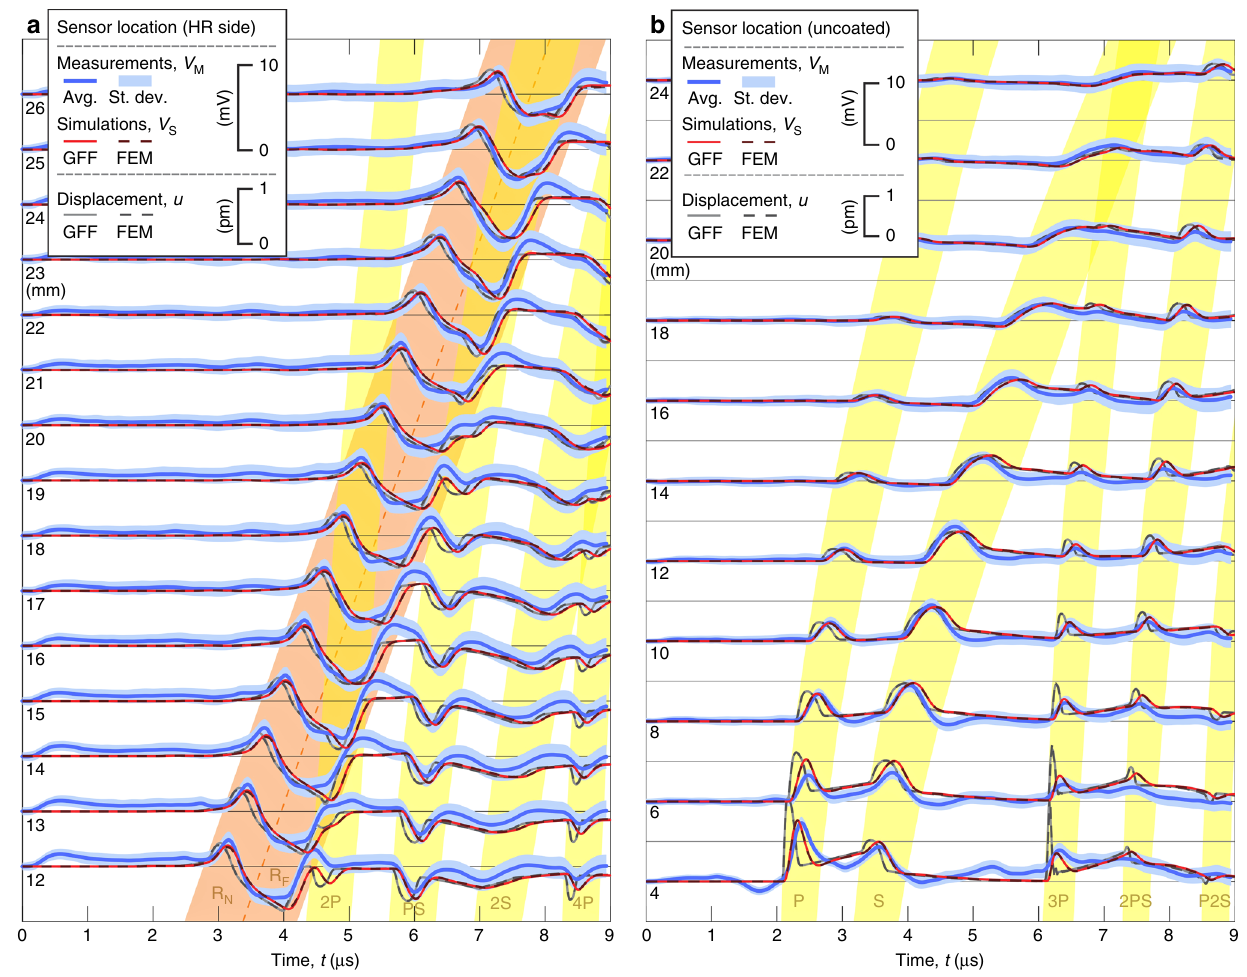
Fig. 2 Experimental and simulated picometer-scale normal surface displacements. The normal surface displacements are caused by the reverberations of radiation-pressure-driven elastic waves within a dielectric mirror. a The waveforms obtained on the illuminated top side of substrate and b on the bottom side of the substrate. The coloured bands identify different wave-types in the measured signals. The yellow bands correspond to the multiply re fl ected bulk waves (P, S, PS, … ), while the orange band corresponds to surface-bound Rayleigh wave (R). Contributions to the Rayleigh wave from the near edge (R N ) and far edge (R F ) of the illuminated area, with respect to the sensor, are resolved. The sensor input u is the normal displacement averaged over the aperture of the PZT sensor. The measured sensor output V M and the simulated output V S using two different simulation approaches, fi nite element modelling (FEM) and Green ’ s function formalism (GFF), show excellent agreement. The modelled waveforms are calculated by considering only radiation pressure as a source of elastic waves and excluding thermoelastic expansion and radial stress. The close match between the measurement and simulations provides clear evidence that the measured surface displacement fi eld is caused predominantly by radiation pressure